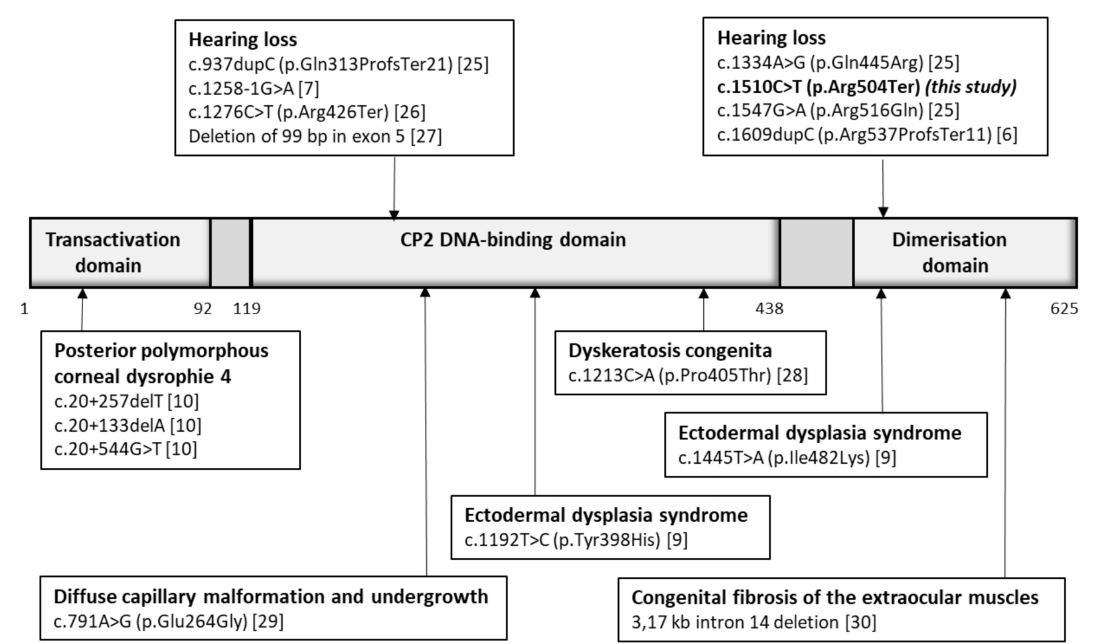
Figure 4. Schematic presentation of the functional domains of the GRHL2 protein, with the location of known disease- causing variants grouped by specific disorder (reference sequences for the variants or amino acid numbering of the protein domains were NM_024915 and